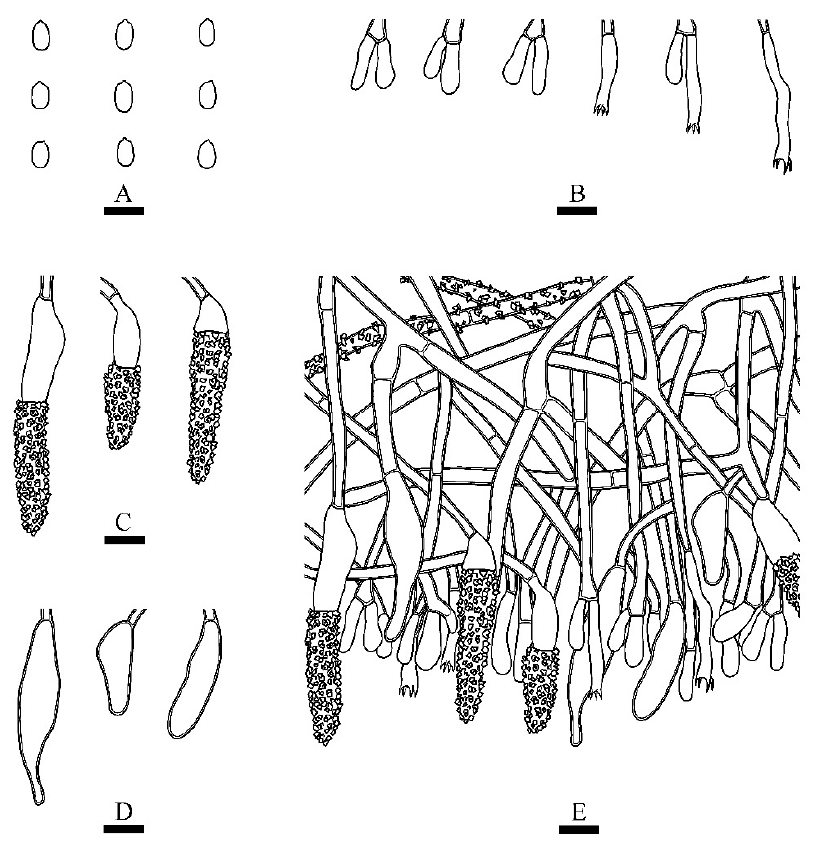
Figure 4. Microscopic structures of Rhizochaete fissurata (holotype): ( A ) basidiospores; ( B )